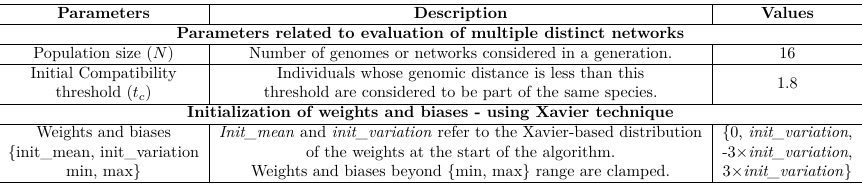
Table 1: InfoNEAT parameters to be set by the